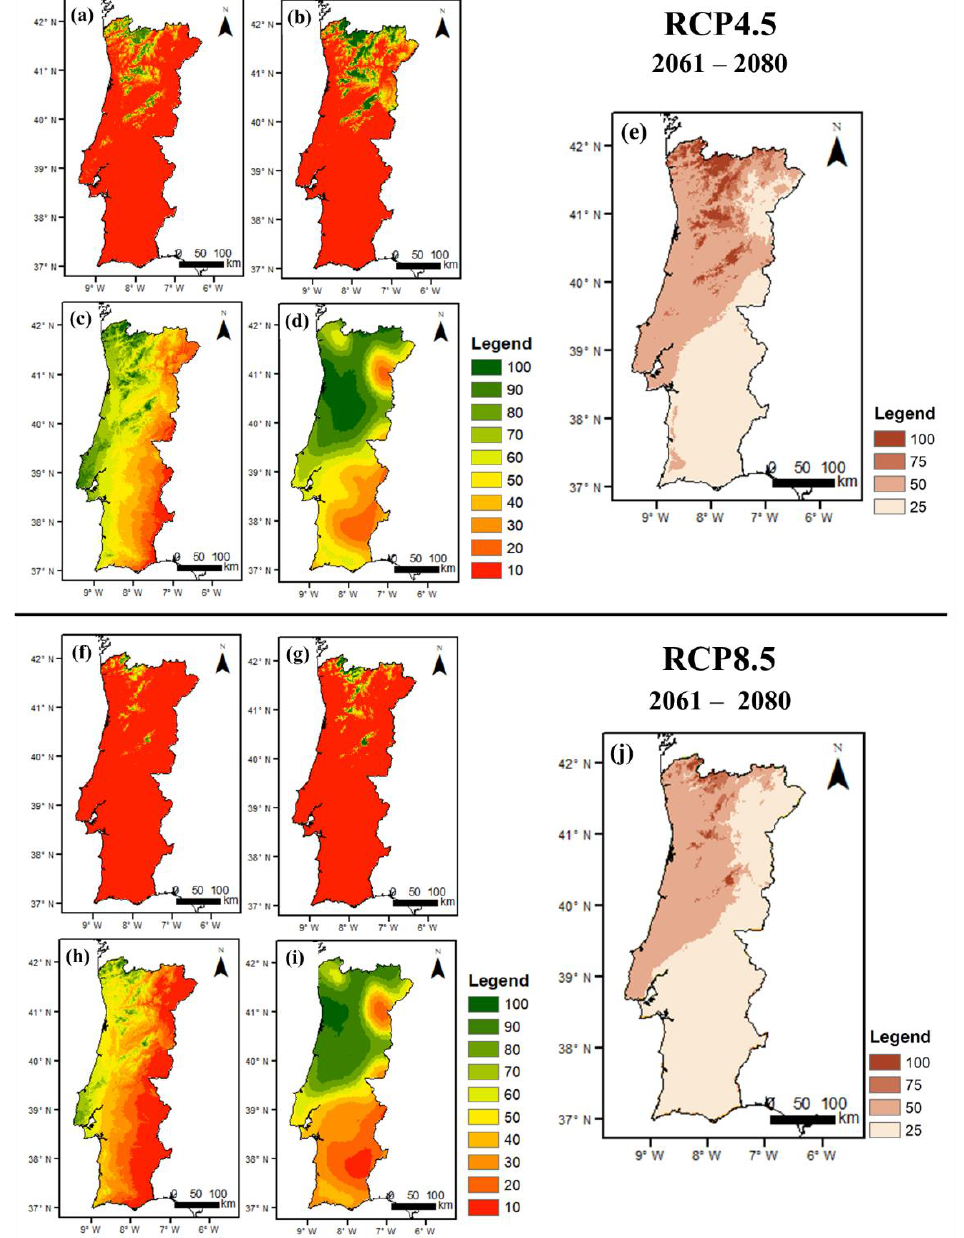
Figure 6. Mean percentage of occurrence of ( a , f ) growing degrees days between 1900 and 2400 ◦ C, ( b , g ) annual mean temperature between 8 and 15 ◦ C, ( c , h ) summer days with maximum temperature below 32 ◦ C, ( d , i ) annual accumulated precipitation between 600 and 1600 mm, and ( e , j ) chestnut suitability index, for 2061–2080, four GCM-RCM experiments, under RCP4.5 (top panel) and RCP8.5 (bottom